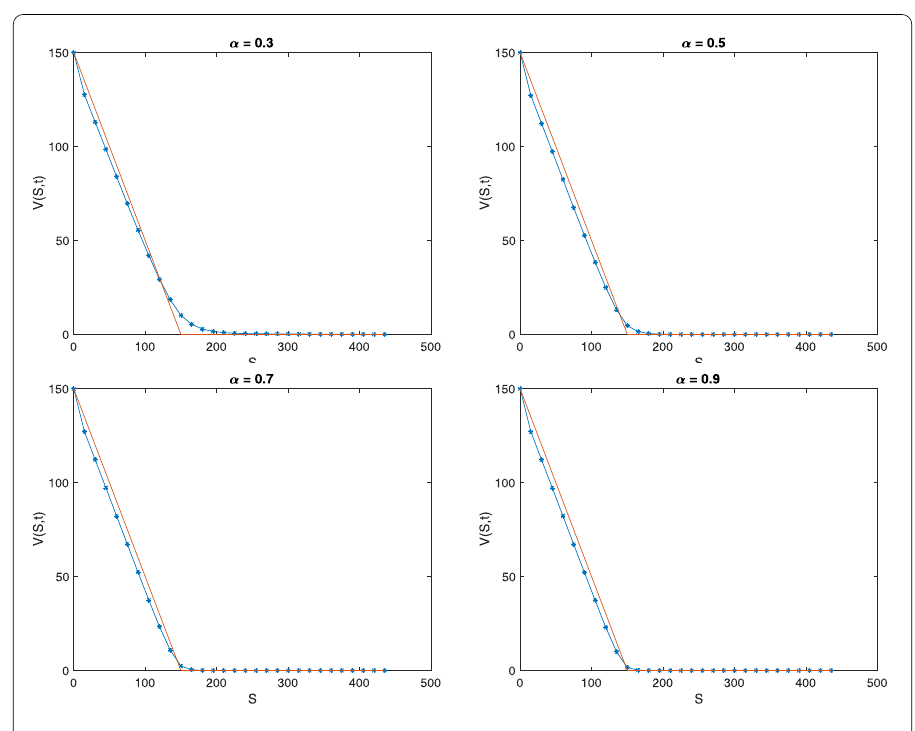
Figure 2 Payoffs under Example 5.1 for α = 0.3,0.5,0.7,0.9; δ = 0.045 at t = T